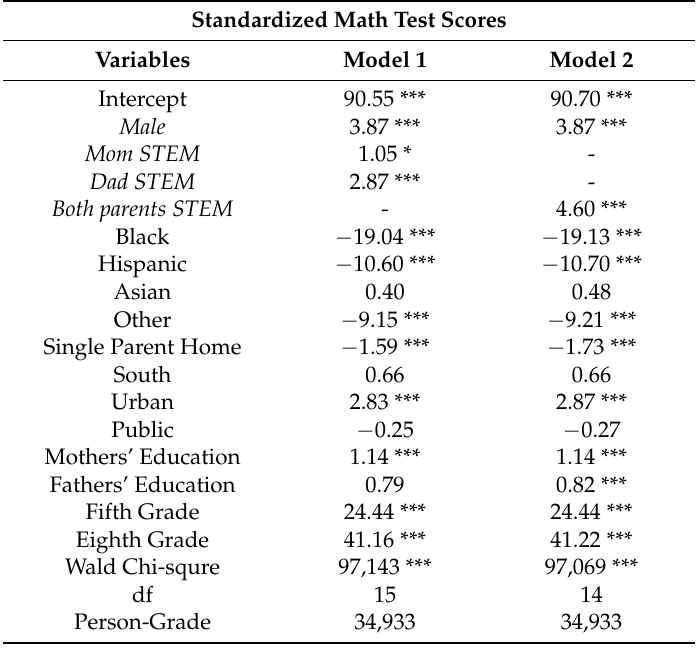
Table 2. Random effects models to predict standardized math test scores.